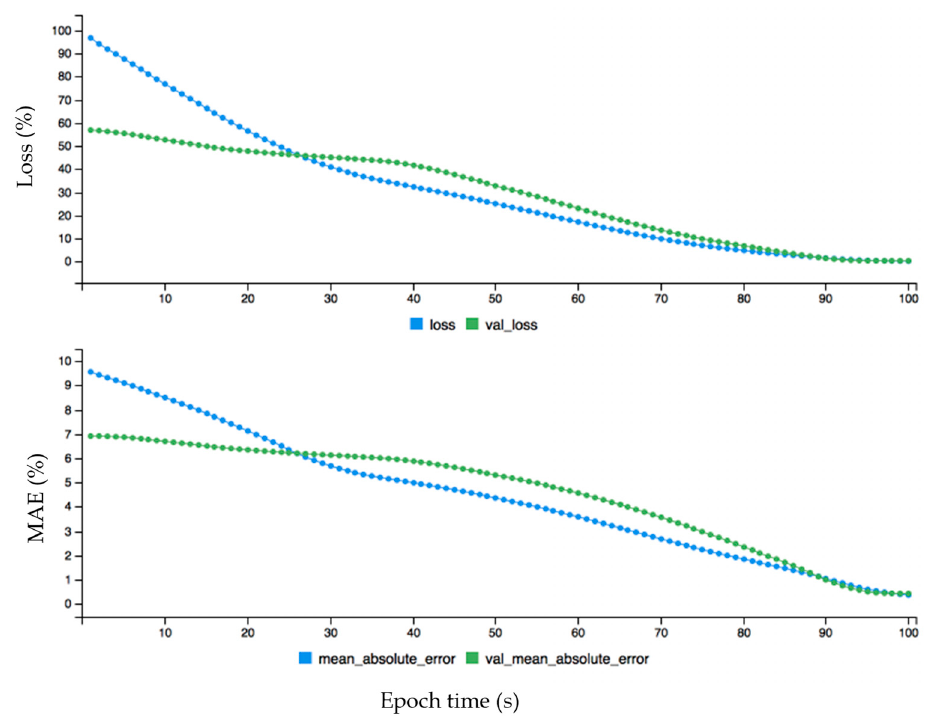
Figure 11. The dynamic plot of forecasting error before fine-tuning configuration for annual wind data.